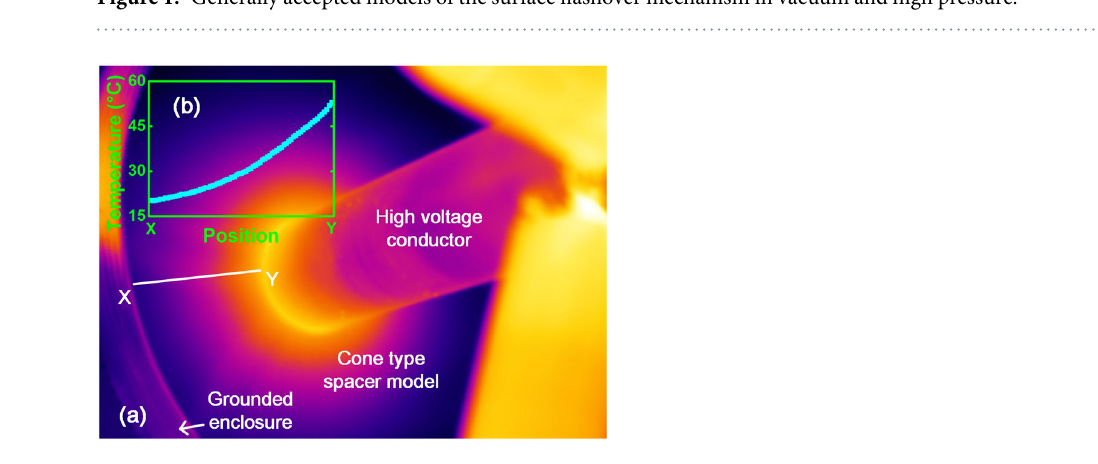
Figure 1. Generally accepted models of the surface flashover mechanism in vacuum and high pressure.